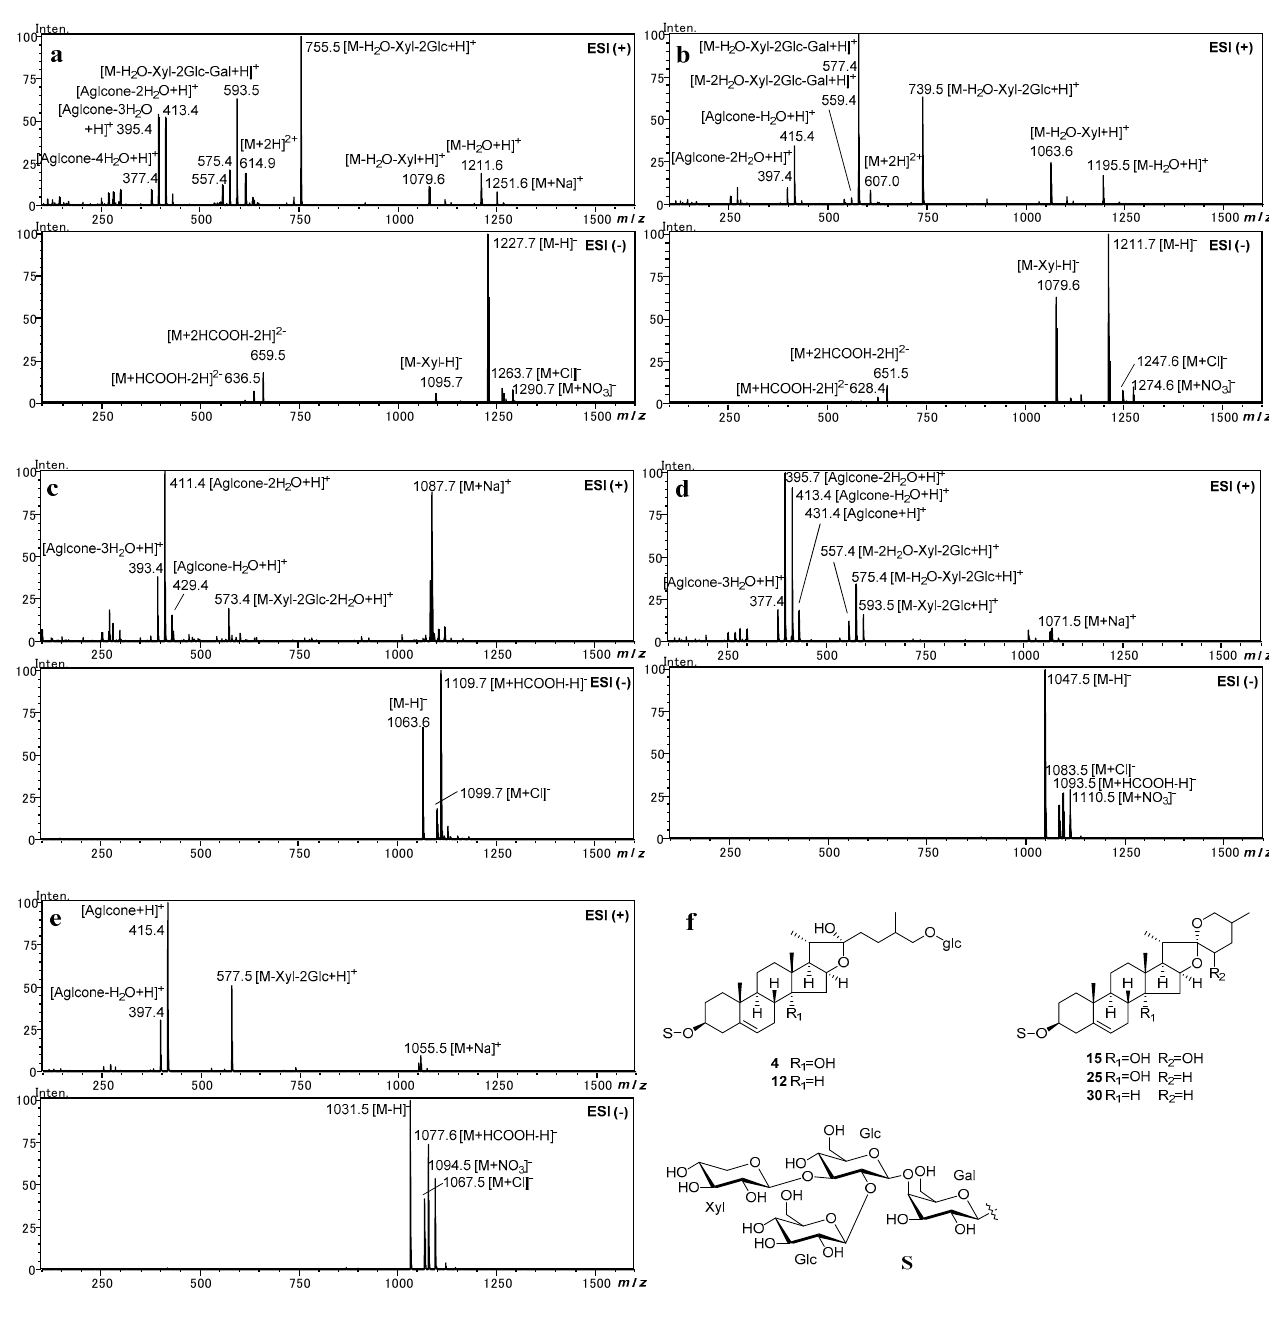
the loss of a galactosyl residue (162 Da) to generate [M-H 2 O-Xyl-2Glc-Gal+H] + at m / z 593 and 577, respectively. The fragmentation was in good agreement with the C-3 sugar moiety to be a lycotetraose ( S3 ) (Figure 2).